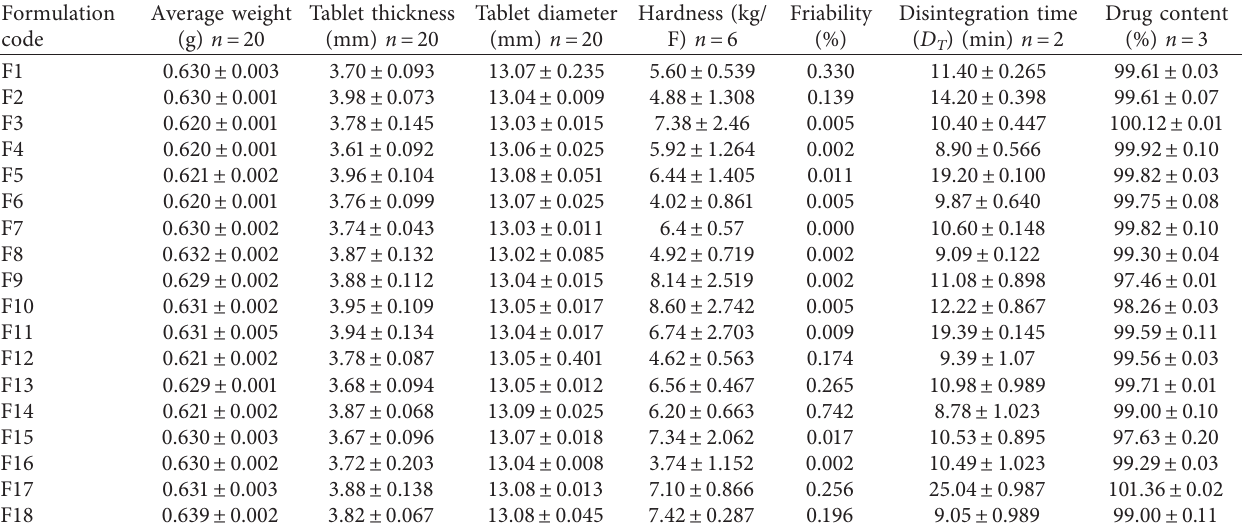
Table 4: Physical and mechanical properties of paracetamol batches produced using different concentrations of the okra pectin as